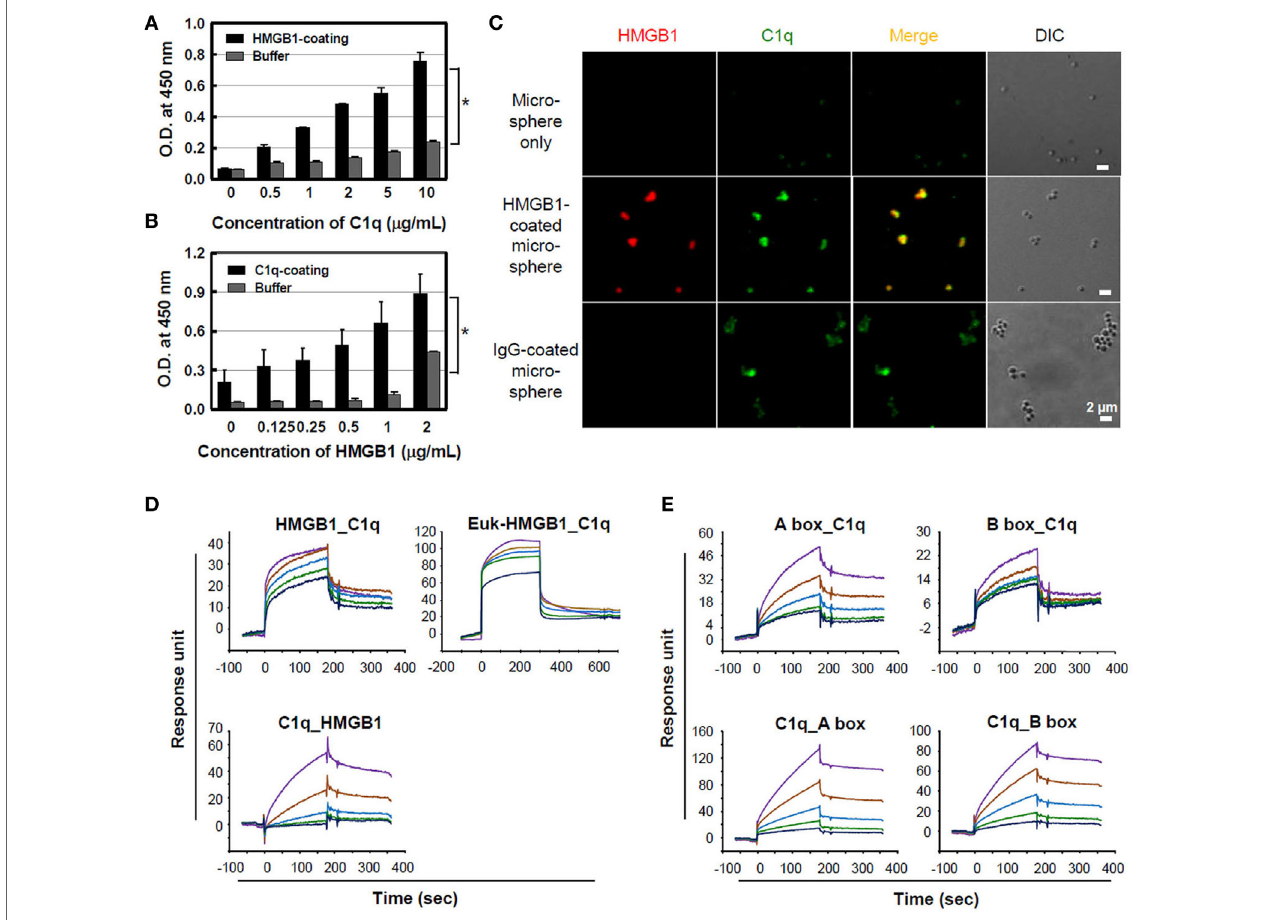
FigUre 1 | Binding of high-mobility group box 1 (HMGB1) to C1q. (a) Purified C1q protein (10 µg/ml) was immobilized on a microtiter plate, and different concentrations of HMGB1 protein were added for an enzyme-linked immunosorbent assay (ELISA). Buffer was used as a negative control. Data are representative of three independent experiments. Error bars are mean ± SD. * P < 0.05 by Student’s paired t -test. (B) HMGB1 (3 µg/ml) was immobilized and incubated with various concentrations of C1q for the ELISA. Data are representative of three independent experiments. Error bars are mean ± SD. * P < 0.05 by Student’s paired t -test. (c) HMGB1 protein was biotinylated and incubated with streptavidin-coated microspheres. HMGB1-coated microspheres were incubated with 10% normal human serum, which was pre-absorbed with non-coated microspheres, for 30 min at 37°C, and immunofluorescence staining was performed with anti-HMGB1 (red) and anti-C1q (green) antibodies. Biotinylated human IgG served as the positive control. Experiments were repeated at least three times and representative data are shown. Scale bar: 2 µm. (D) Surface plasmon resonance (SPR) analyses of HMGB1 binding to C1q protein. HMGB1 protein produced in Escherichia coli (HMGB1) and in eukaryotic cells (Euk-HMGB1 from R&D), left and right panels, respectively, were passed over a C1q-immobilized CM5 dextran sensor chip at concentrations of 1.8, 0.9, 0.45, 0.23, and 0.11 µM (upper panels). The reciprocal experiment of C1q binding to solid-phase HMGB1 protein at the concentrations of 200, 100, 50, 25, and 12.5 nM (lower panel) was also performed. K D = ~400 nM. (e) The interactions between HMGB1 A and B box proteins and C1q- immobilized chip (upper panels) and reciprocal interactions (lower panels) were also evaluated using SPR assays. Both K D = ~4 μ M. Colored lines in each SPR assay represent concentrations of proteins from high to low: purple, brown, blue, green, and